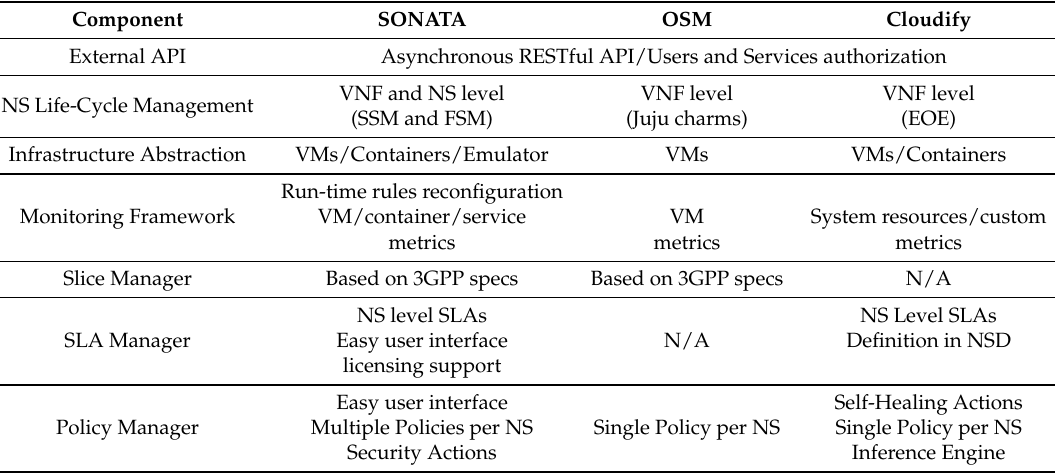
Table 1. MANO characteristics.